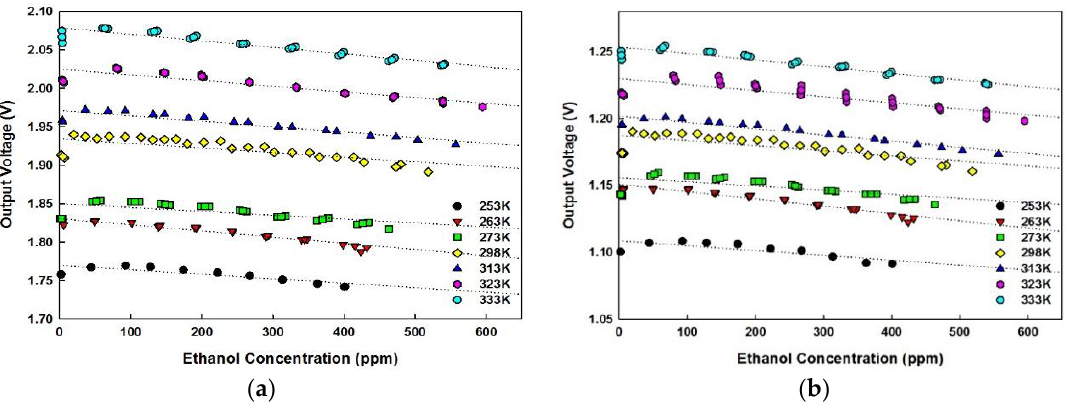
Figure 9. Parylene-C sensor output voltages of ( a ) detector with no disk (2.0 Ø ); ( b ) detector with hollow disk (1.6 Ø ).